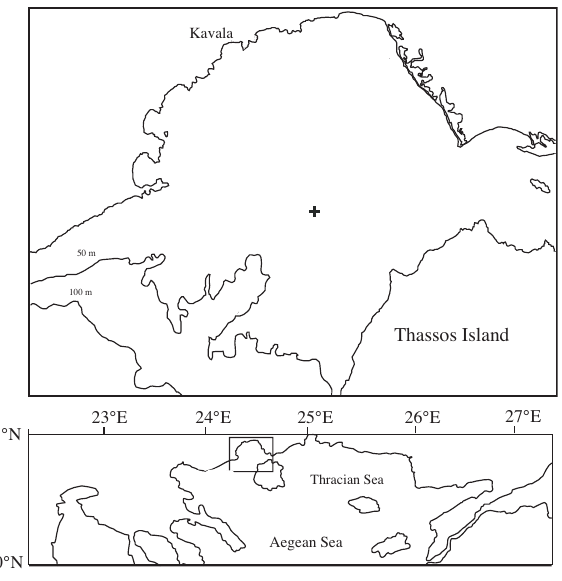
F IG . 1. – Map of the study area (Kavala Gulf, northern Aegean Sea, Greece) showing the station at which temperature data was recorded (+). The depth contours of 50 and 100 m are also